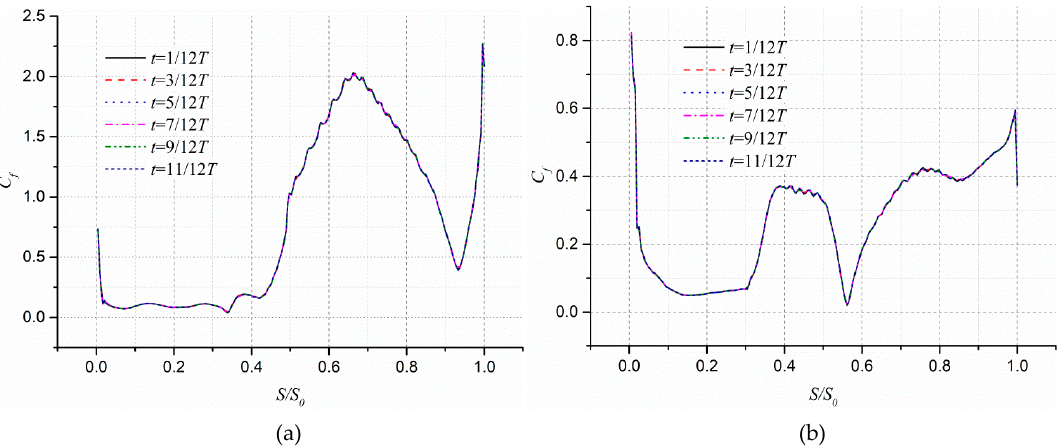
Figure 5. Distribution of pressure coefficient on the blade surface for the Z / b 2 = 0.15 cross section: ( a ) pressure surface and ( b ) suction surface.